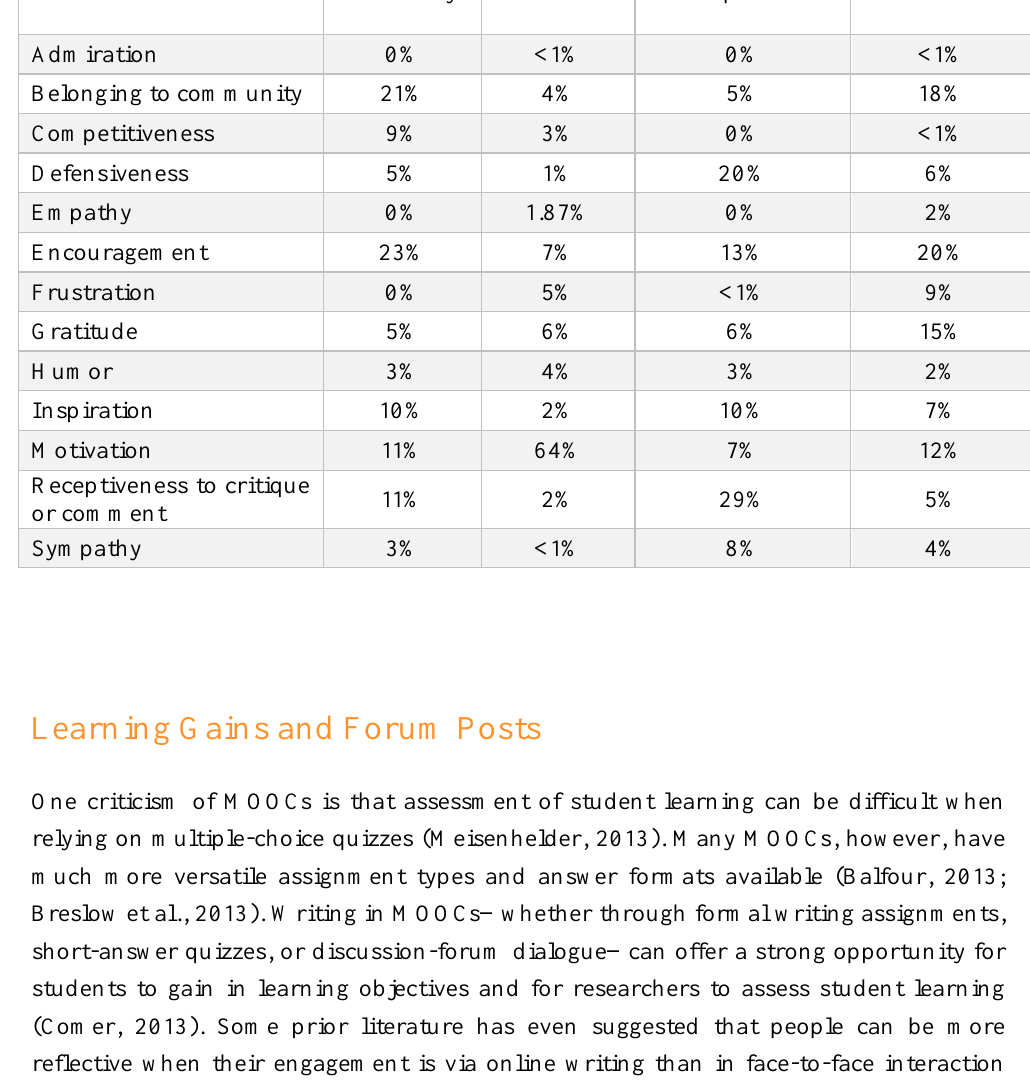
Top posters in English Composition